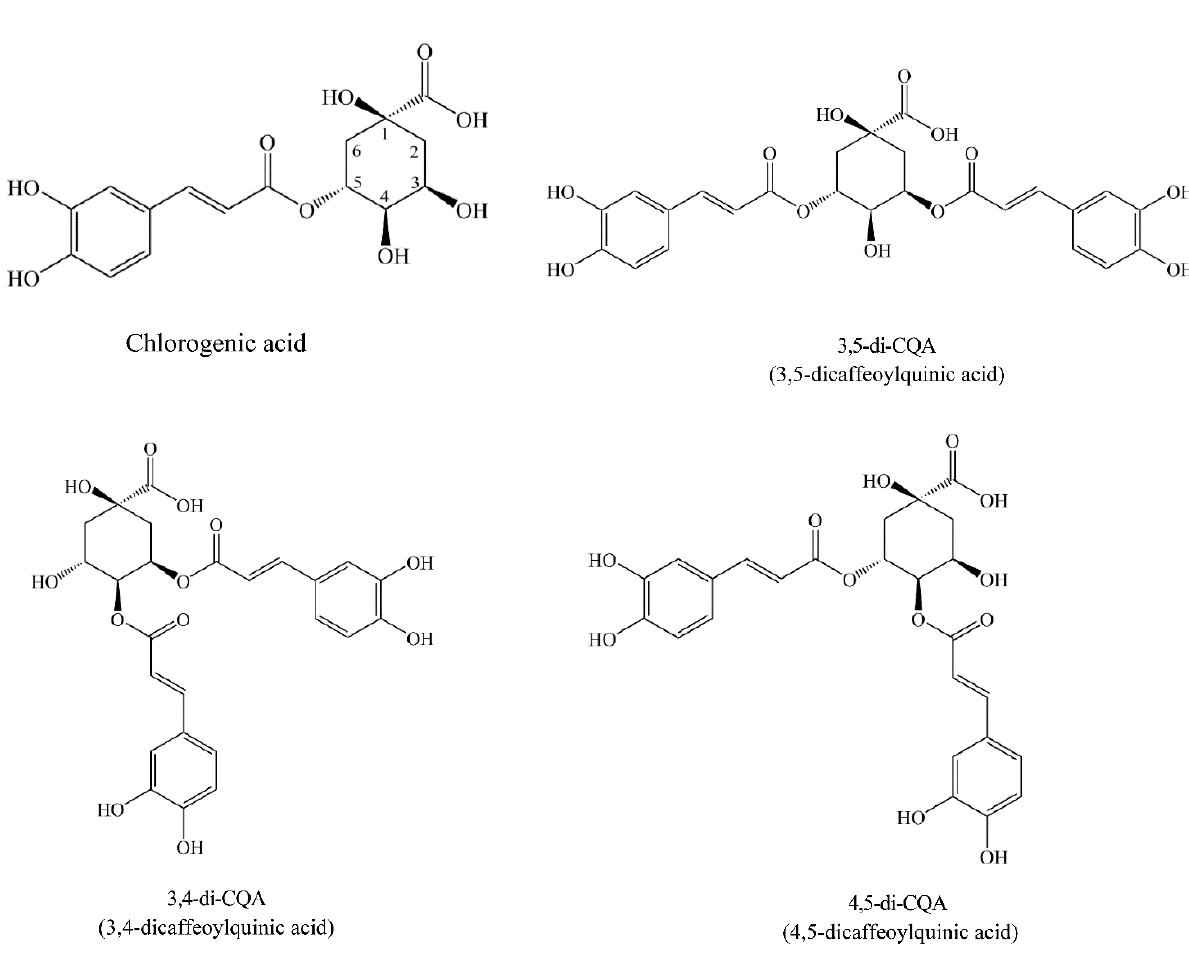
Figure 1. Structure of chlorogenic acid (CGA) and isochlorogenic acids, 3,5-dicaffeoylquinic acid (3,5-di-CQA), 3,4-dicaffeoylquinic acid (3,4-di-CQA), and 4,5-dicaffeoylquinic acid (4,5-di-CQA).